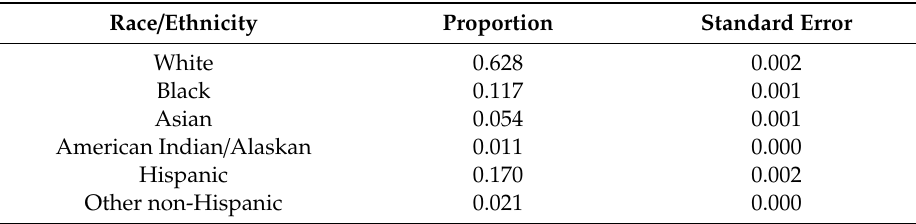
Table 5. Variable IMPRACE: “Imputed race / ethnicity value (This value is the reported race / ethnicity or an imputed race / ethnicity, if the respondent refused to give a race / ethnicity. The value of the imputed race / ethnicity will be the most common race / ethnicity response for that region of the state)